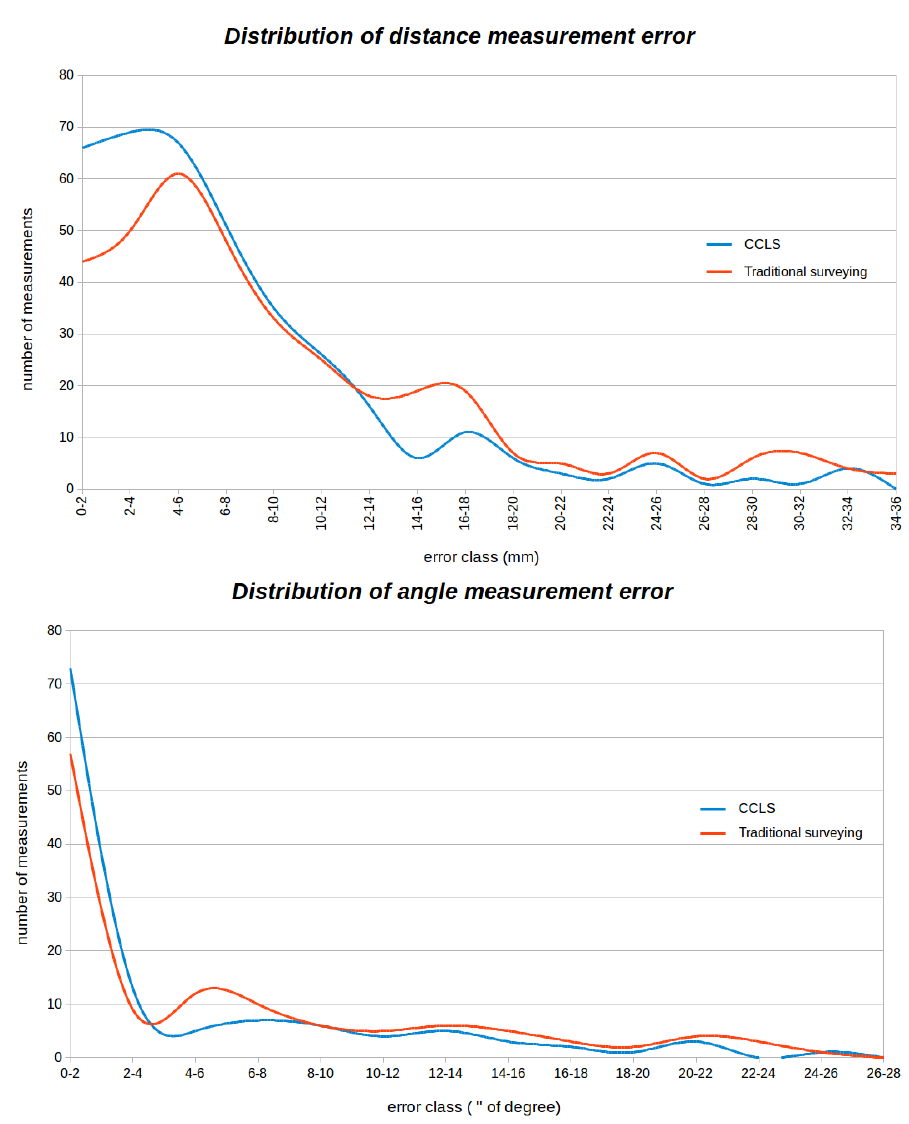
Figure 18: Distribution of the distance (a) and angle (b) measurement